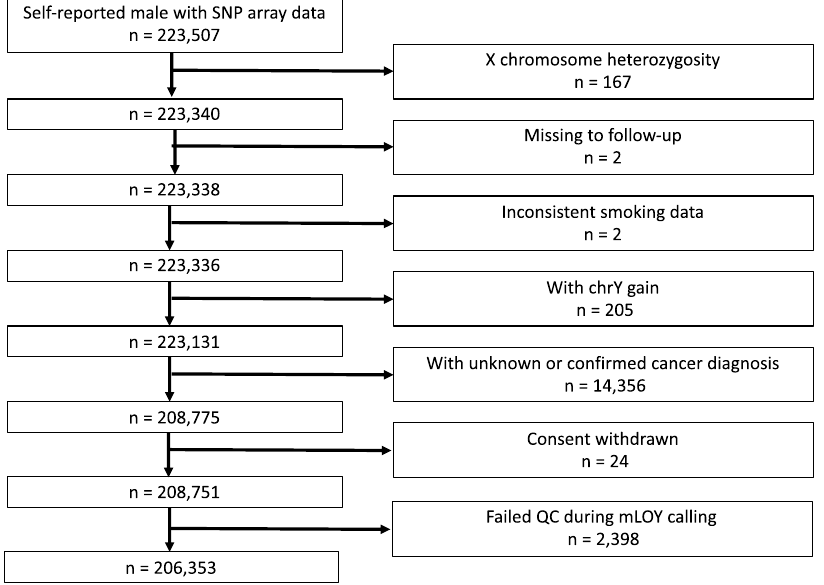
Figure 1. Number of participants. The number of participants excluded by each criterion was